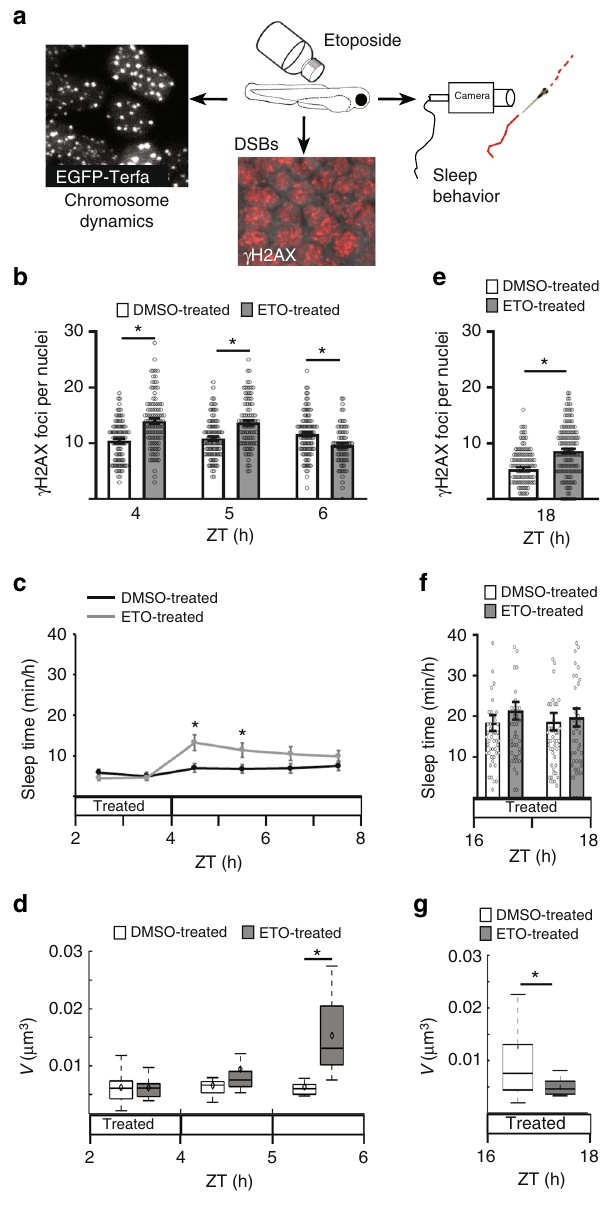
activity reduces chromosome dynamics in a single active cell under spontaneous conditions and optogenetic manipulation.